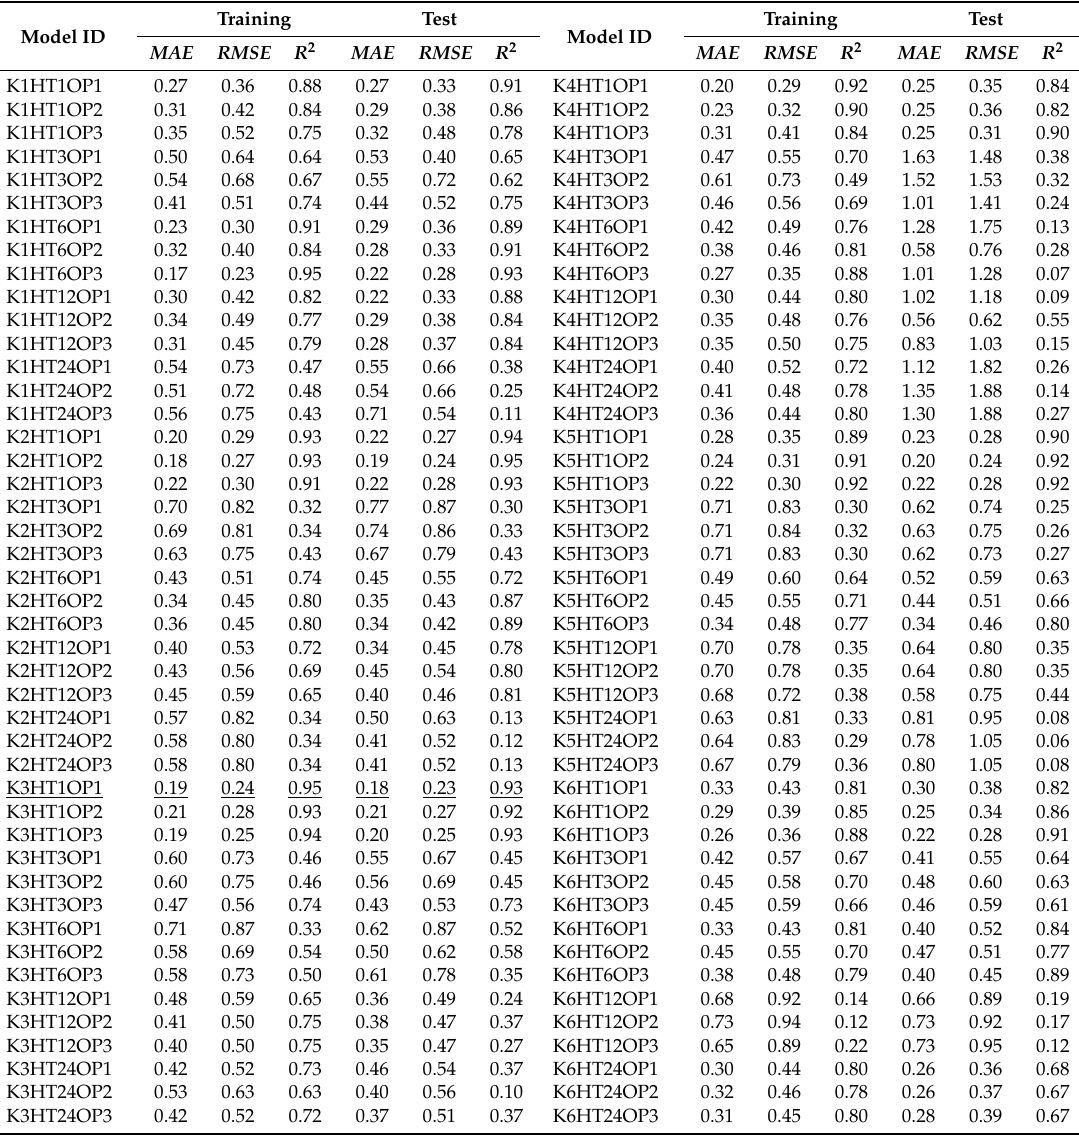
Table A1. Detailed performance of all 90 GEP models in both testing and training